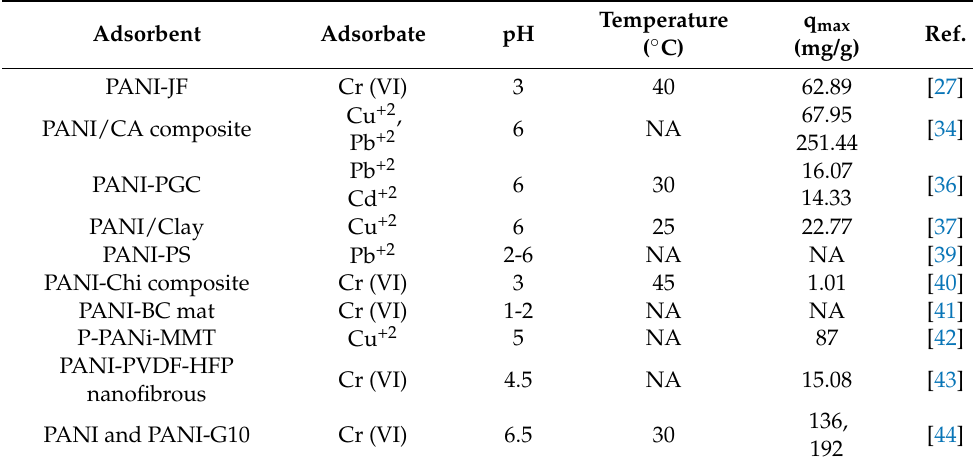
Table 2. PANI-based adsorbents for the removal of HMIs PANI-based adsorbents for the removal of